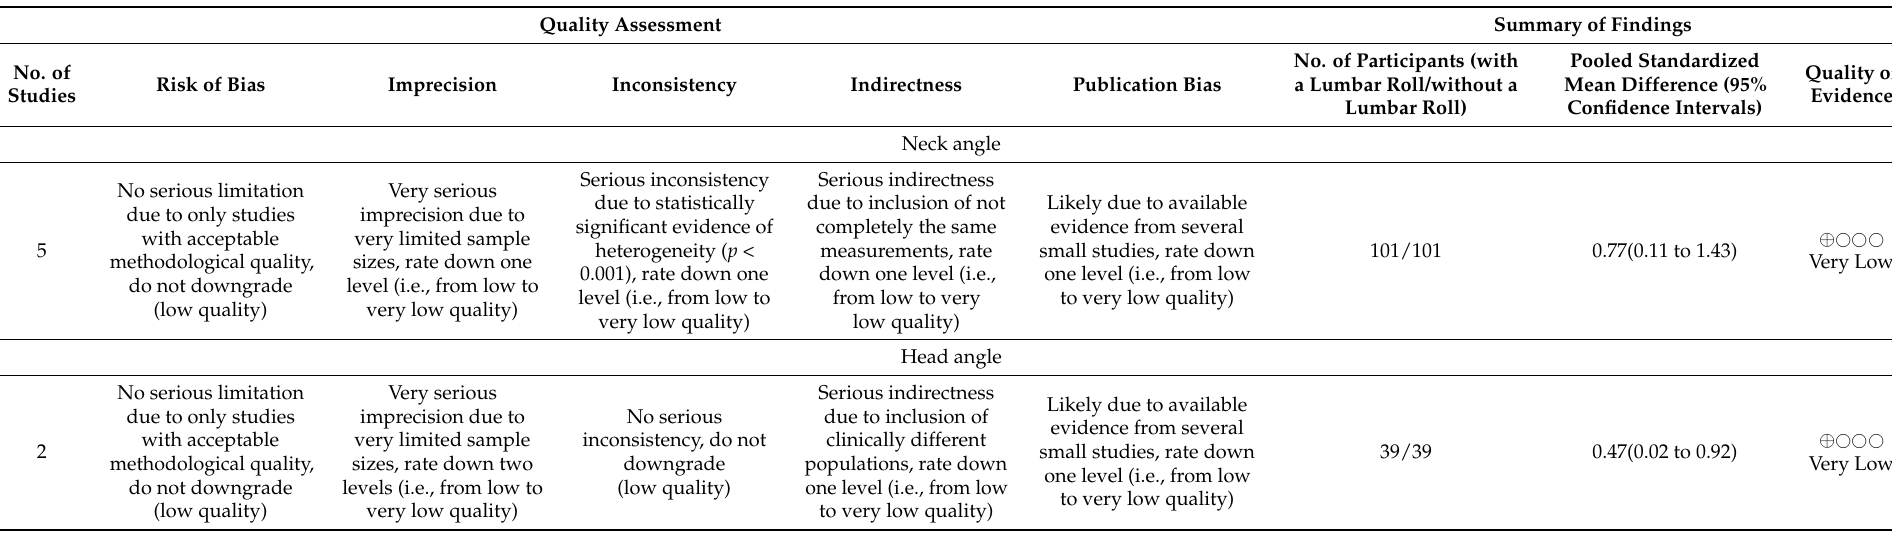
Table 3. Quality of the evidence using the Grading of Recommendations Assessment, Development, and Evaluation